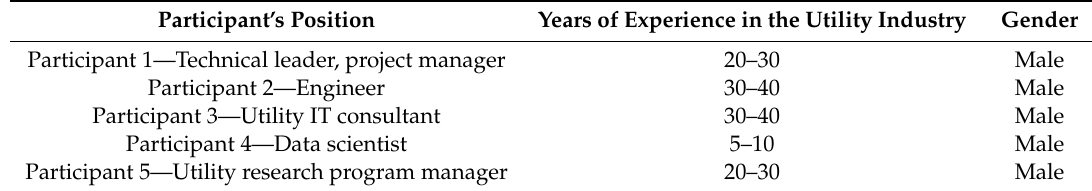
Table 2. Survey Participants Sample Characteristics. IT: information technology.